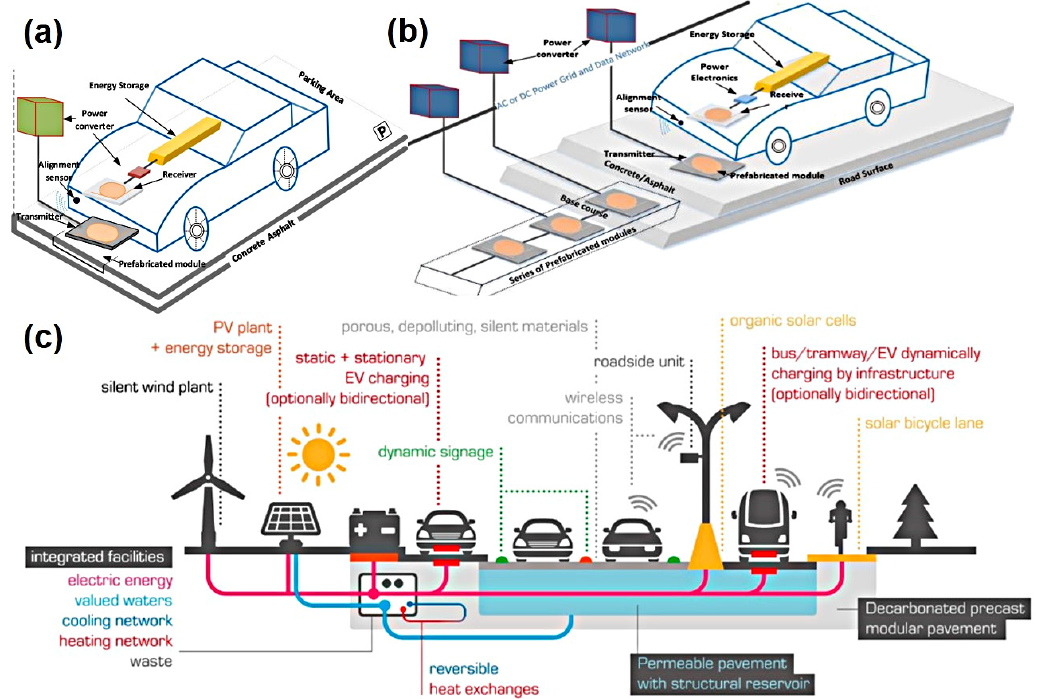
Figure 2. ( a ) Stationary wireless charging [29]; ( b ) Dynamic wireless charging [29]; ( c ) Vision of the future smart city wireless charging system [30].